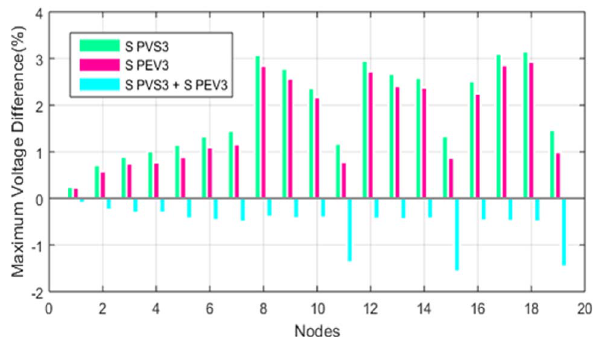
Figure 12. Analysis of daily pro fi les of phase voltage for summer.